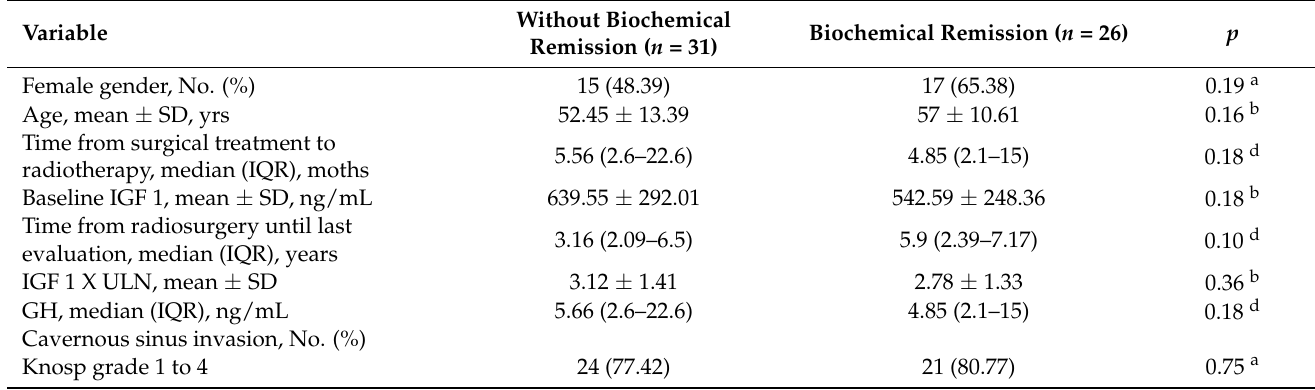
Table 3. Comparison of baseline characteristics between the active and non-active groups at the end of follow-up ( n =